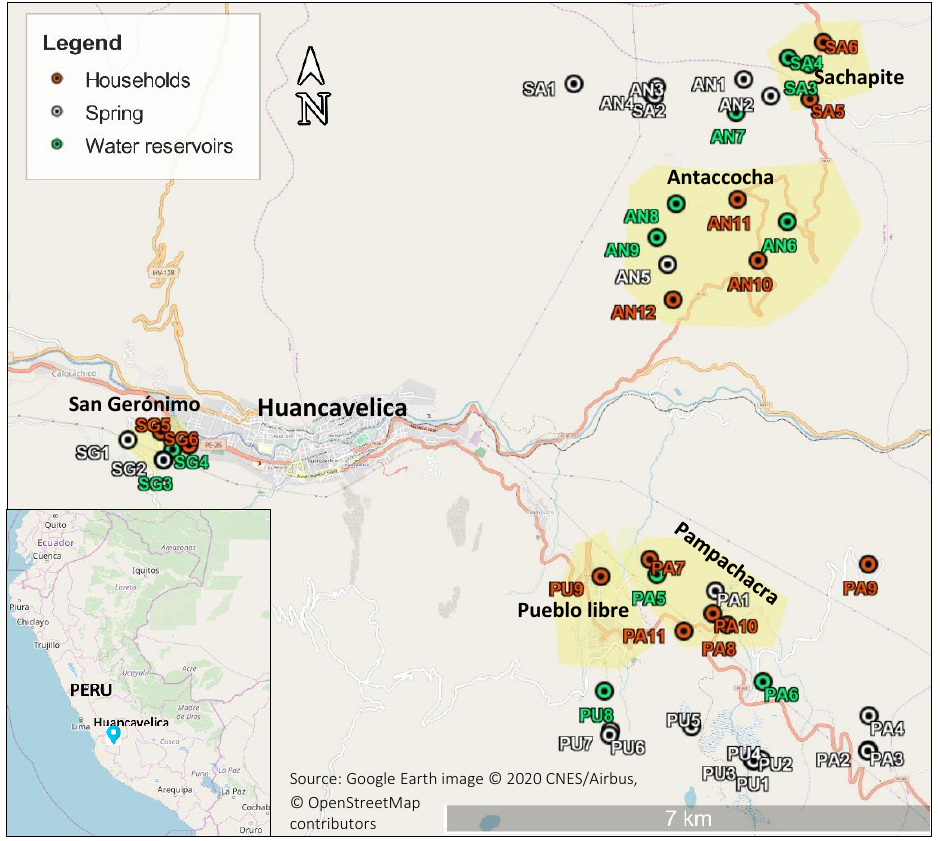
Figure 1. Geographical location of sampling points in communities. Table 1. Number of sampling points per community .